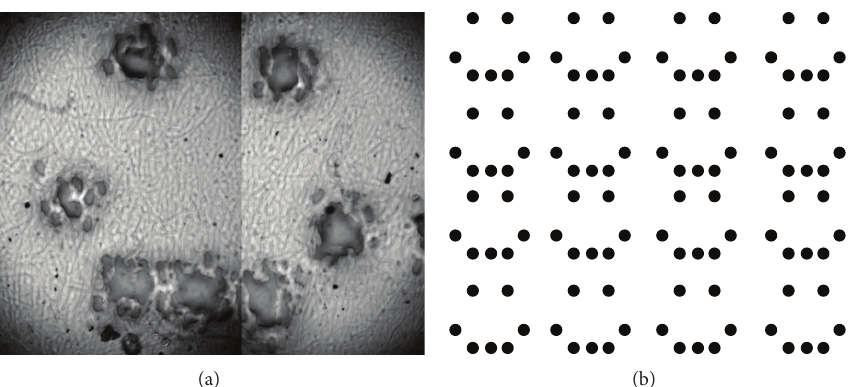
Figure 6: Selective irradiation of gels through application of ascorbic acid solution. (a) Resultant pattern after immersion in hot water under 40x magnification. (b) Original computer-generated